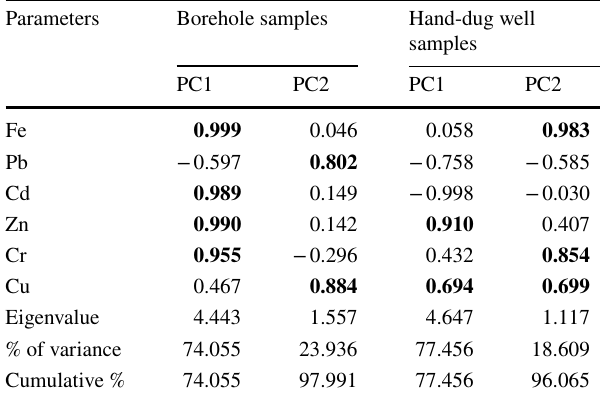
High loadings are indicated in